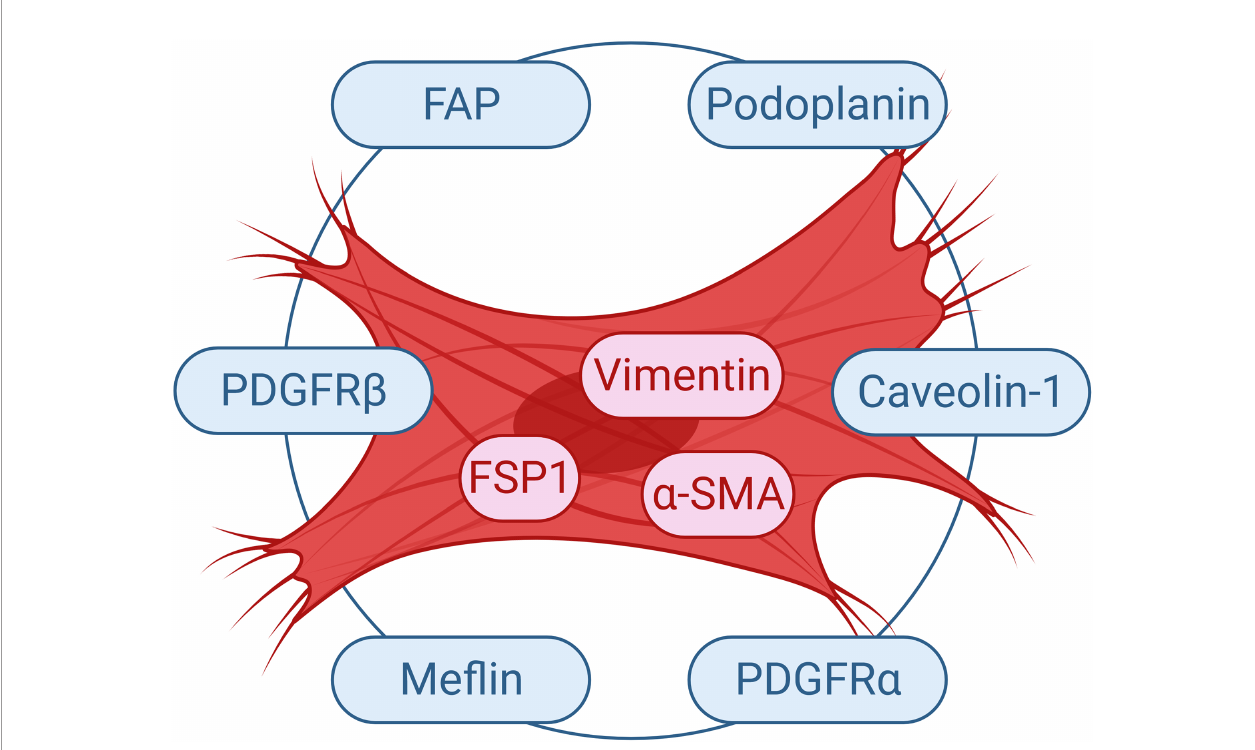
FIGURE 3 | Commonly Used Markers for CAFs. Selected markers used to study CAF cells are demonstrated. FAP, fi broblast activation protein; FSP1, fi broblast- speci fi c protein 1; PDGFR, platelet-derived growth factor receptor; a -SMA, a -smooth muscle actin.